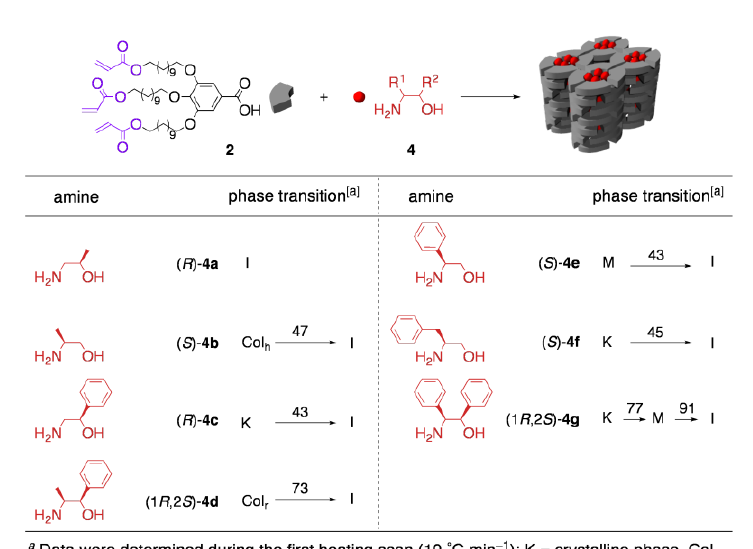
Table 1. Phase transition behavior of the salts of a polymerizable carboxylic acid ( 2 ) with various 2-amino alcohols ( 4a – 4g